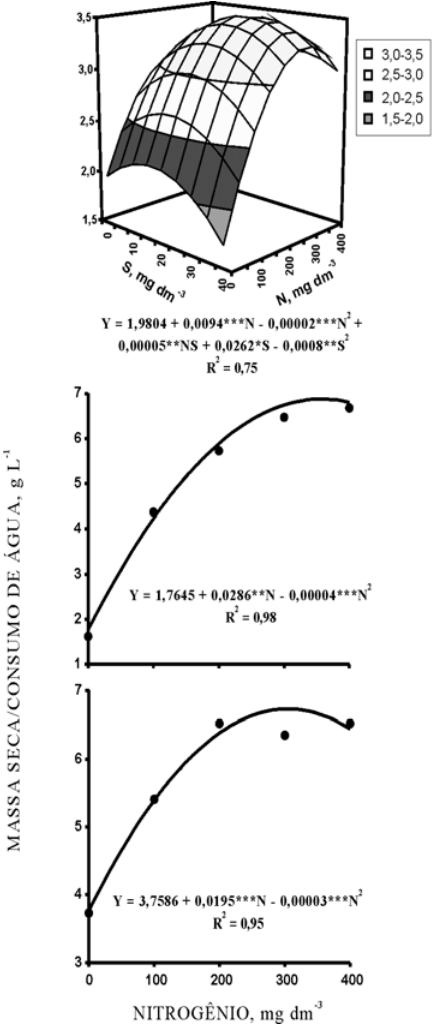
Figura 5. Eficiência do capim-braquiária no uso de água no primeiro crescimento (a), considerando a adubação com doses de nitrogênio e enxofre, e no segundo e terceiro crescimentos (b e c), considerando a adubação com doses de nitrogênio. *** ; ** e * Significativo a 0,1; 1 e 5 %,